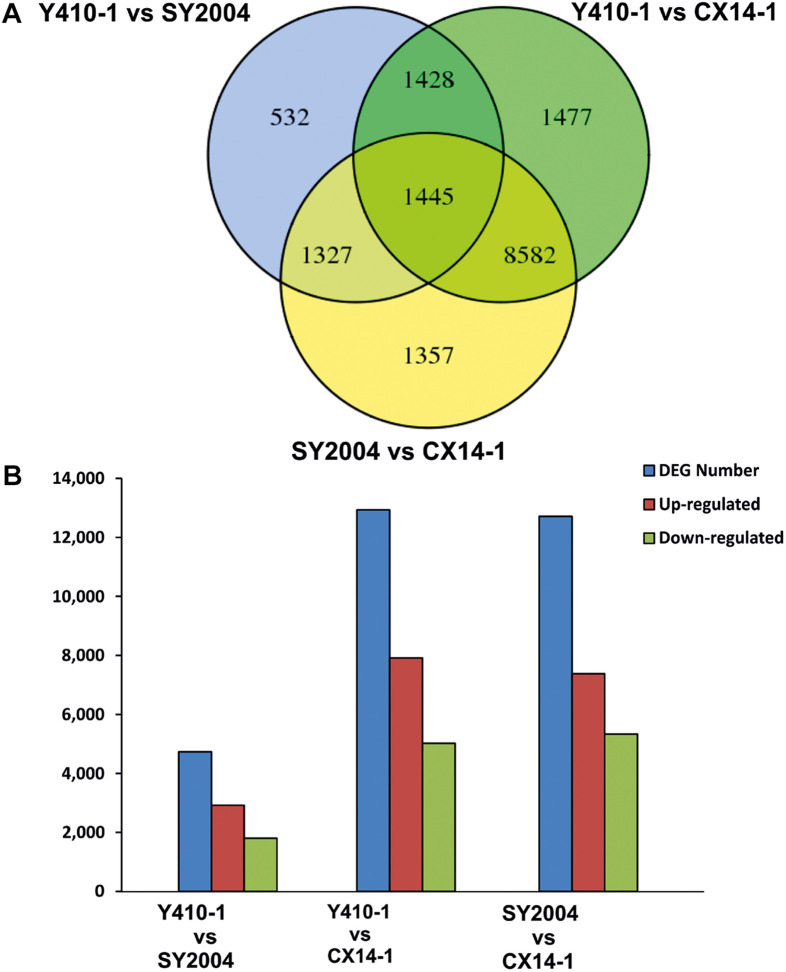
Differentially expressed genes (DEGs) between early- and late-bolting Chinese cabbage double haploid lines. (A) Venn diagram DEGs identified through pairwise comparisons. (B) Number of up- and downregulated genes in each comparison. Venn diagram was generated using the freely available VENNY 2.1 online tool (http://bioinfogp.cnb.csic.es/tools/venny/).